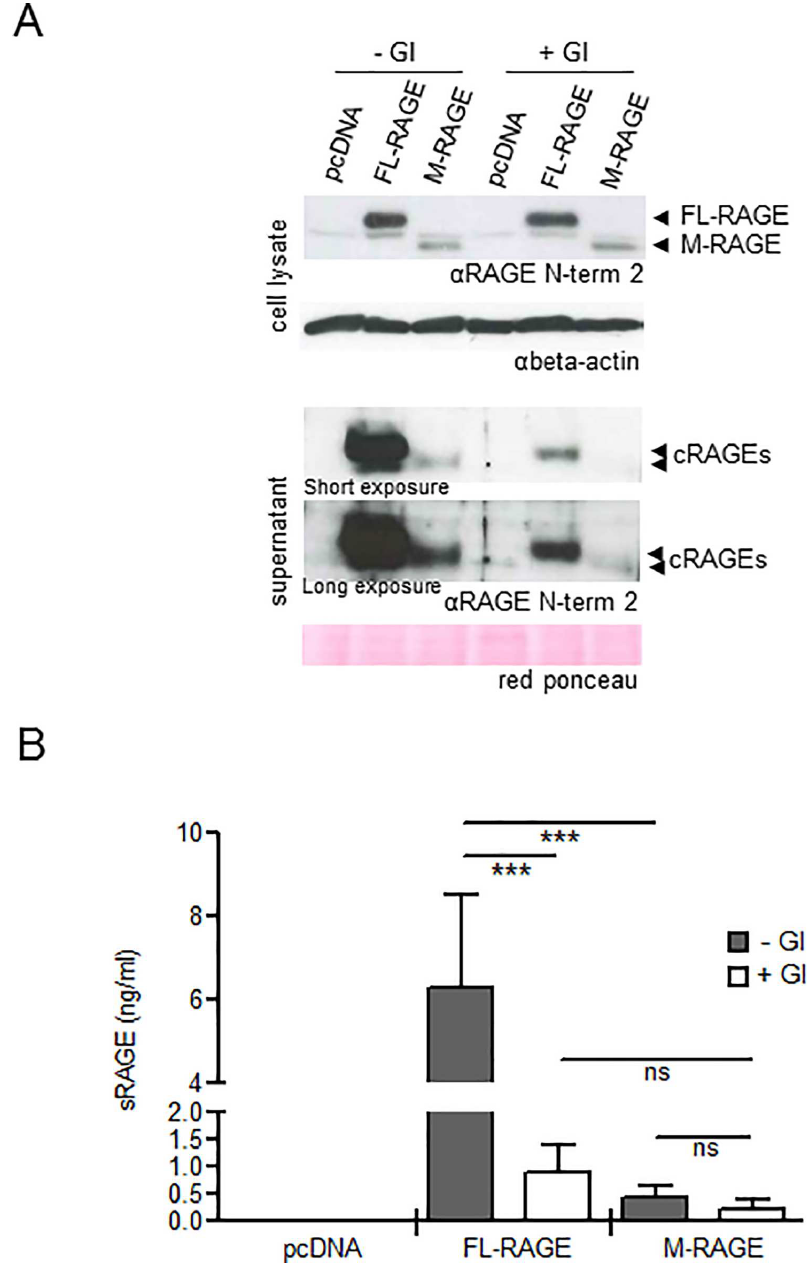
Fig 4. Effect of ADAM10activity on FL-RAGE and M-RAGE cleavage. (A, B) R3/1 cells were transfected with the indicatedvectors, treated or not with an ADAM10 inhibitor(GI), and processedas describedin Materials and Methods. (A) Representative WB of cell lysates (50 μ g) and supernatants of R3/1 cells. Because of the variable levels of cRAGEs in the supernatants of R3/1 cells, short and long exposuresof the same membrane are shown. Beta-actin and red Ponceau staining were used as loadingcontrol for cell lysates and supernatants, respectively. (B) Quantification of cRAGEs in the supernatant of transfected R3/1 cells by ELISA assay. R3/1 cells were transfected with different efficiency and the volume of supernatants tested was adjusted accordingly.Data are mean ± SD (N = 3; *** , P (cid:20) 0.0001; ns, not significant; a.u., arbitrary